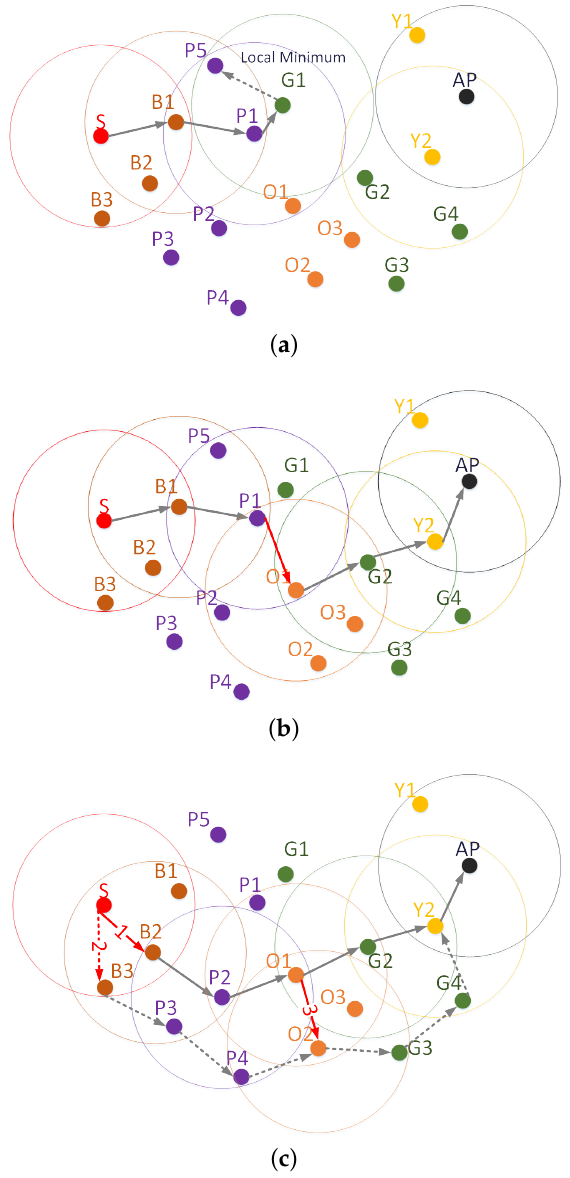
Figure 2. An example that shows how Simulated Annealing (SA) could help routing protocols avoid local minimum scenarios. ( a ) Node G1 (or P5 if Tabu is used) is the last hop in the path between S and AP. The path S to G1 (or P5) was built using greedy forwarding. Greedy forwarding can lead to “local minimums”. ( b ) There is a high probability p to forward the packet randomly, according to the SA principle, when it arrives at P1 because the improvement in the distance (numerator in Equation (1)) by selecting G1 is little. ( c ) There is a high probability p to forward the packet randomly at the beginning of the path from S to AP because the distance to the destination is long (denominator in Equation